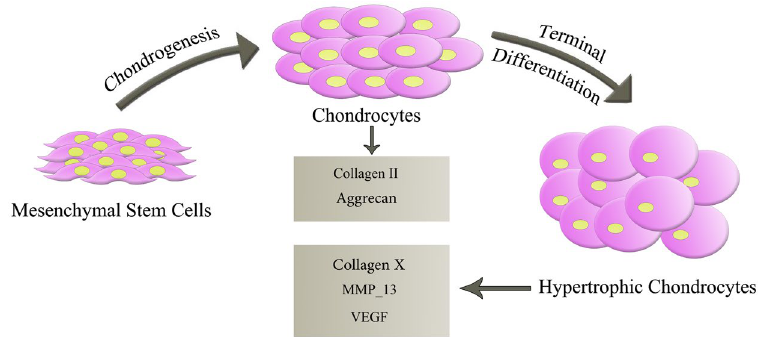
Figure 1. Schematic presentation of cartilage life